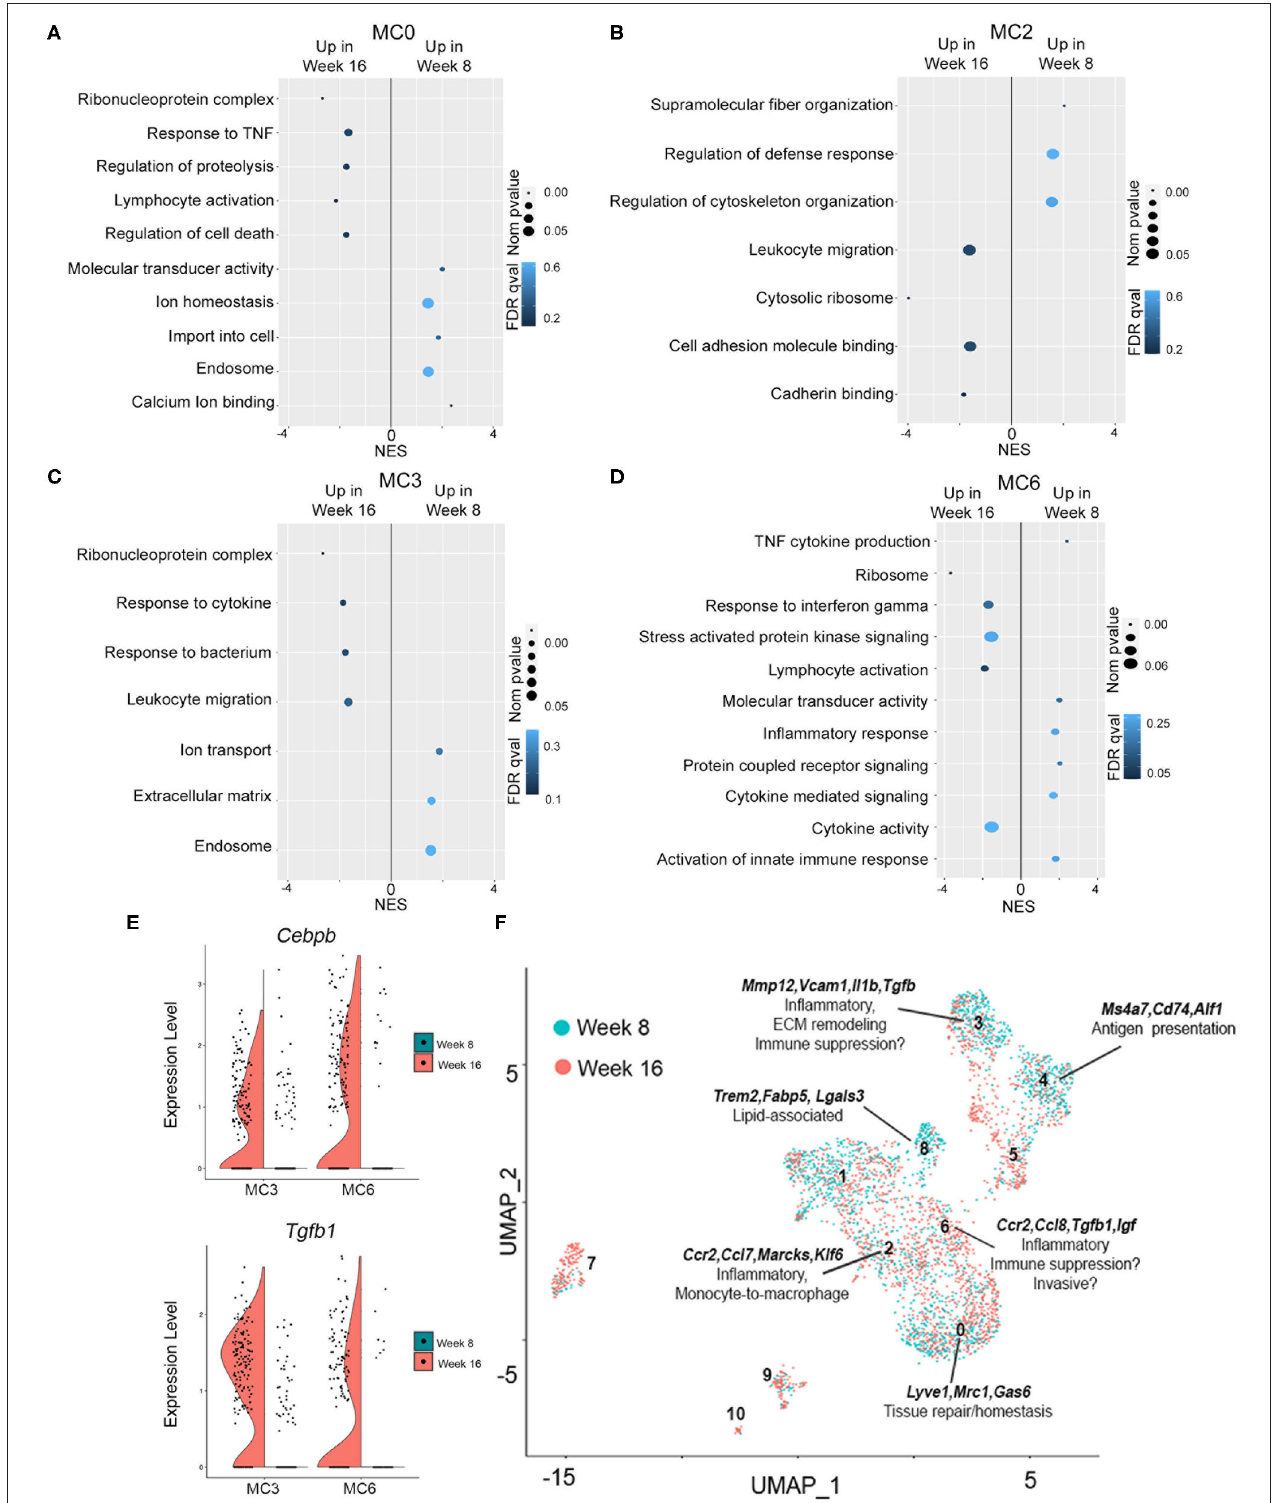
FIGURE 6 | Gene expression in pre-invasive as compared invasive lesions. (A–D) Plots show p -value ( < 0.05), FDR ( < 1) and enrichment score (NES) for genes significantly upregulated at 16 or 8 weeks for myeloid clusters 0 (A) , 2 (B) , 3 (C) , or 6 (D) . (E) Violin plots demonstrating gene expression of Cebpb and Tgfb1 at week 16 as compared to week 8 in myeloid clusters 3 and 6. (F) UMAP shows myeloid clusters 0–10 at week 8 (blue) and week 16 (red) of progression. Defining genes are displayed for each macrophage cluster, and potential functions are hypothesized.